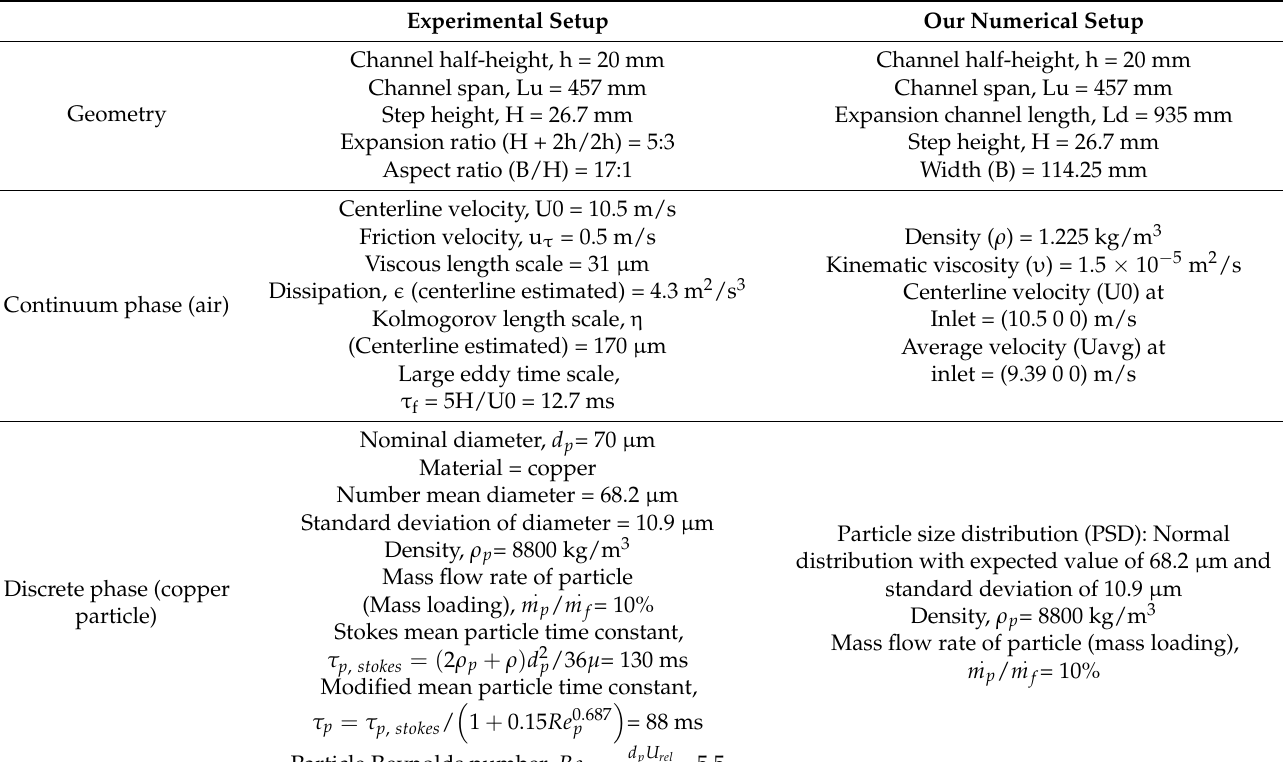
Table 1. Geometry, fluid, and particle phase characteristics in the original experiment [53] and their corresponding setting for the numerical